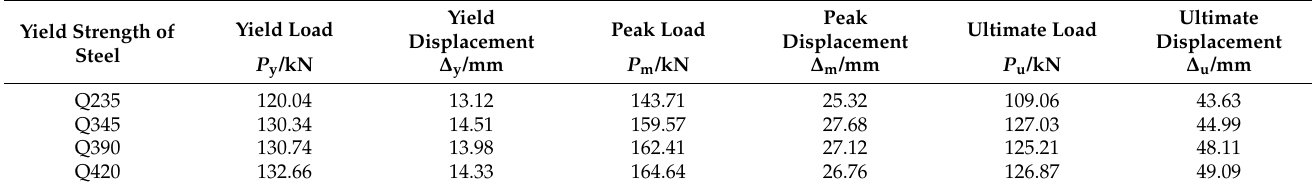
Figure 18. Influence of yield strength of profile steel on composite joints. Table 6. Influence of yield strength of profile steel on characteristic points of composite joints.